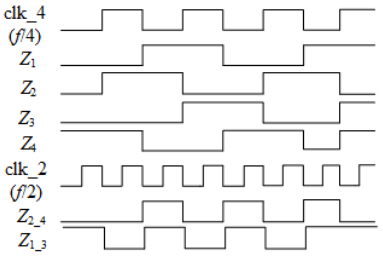
Figure 3. The timing diagram of Z 1 , Z 3 , Z 1_3 , Z 2 , Z 4 , and Z 2_4 .